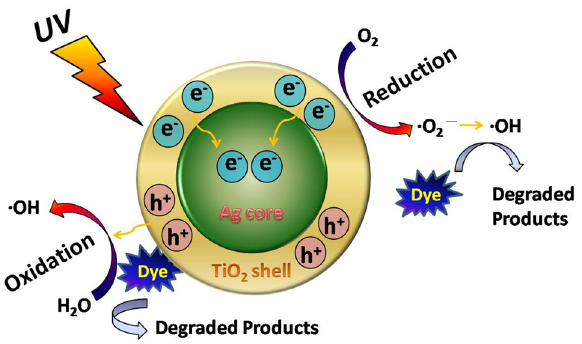
Figure 4. ( a ) Effect of Ag@mTiO 2 dosage on photocatalytic degradation of MB. ( b ) Kinetic plots of − ln(C/C 0 ) versus